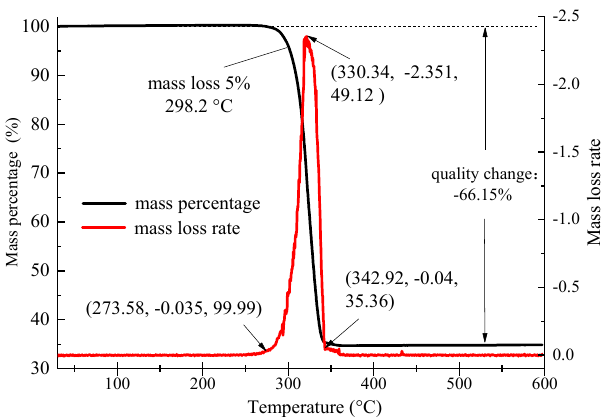
Figure 3. Thermogravimetric curve of the PCTIA.